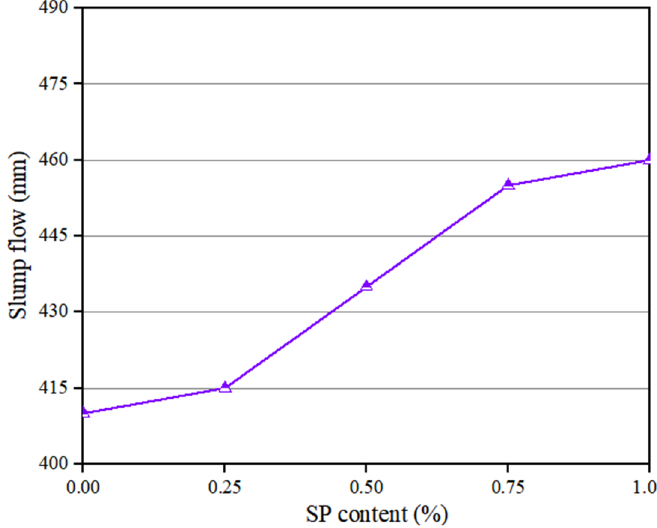
Figure 4. Influence of SP on flowability of geopolymer composites.